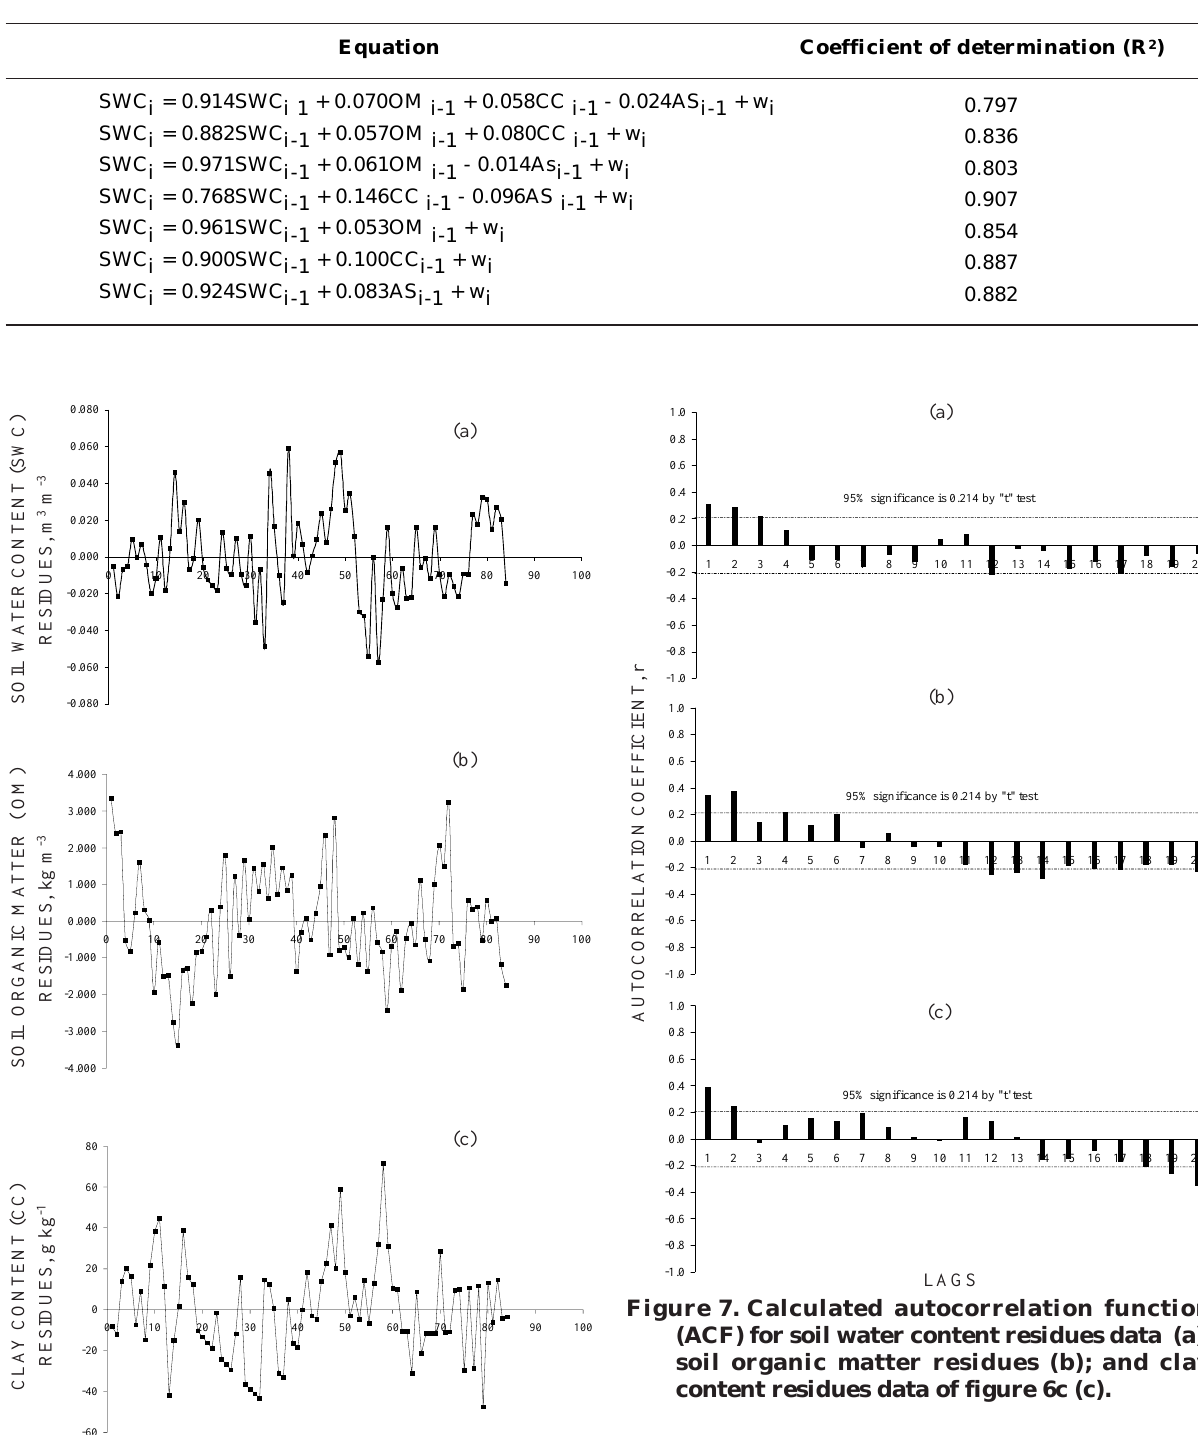
Table 2. State-space equations of soil water content (SWC) using the soil organic matter data (OM), clay content data (CC), aggregate stability data (AS), and values of R 2 from linear regression between estimated and measured values of SWC. All observations have been scaled using equation